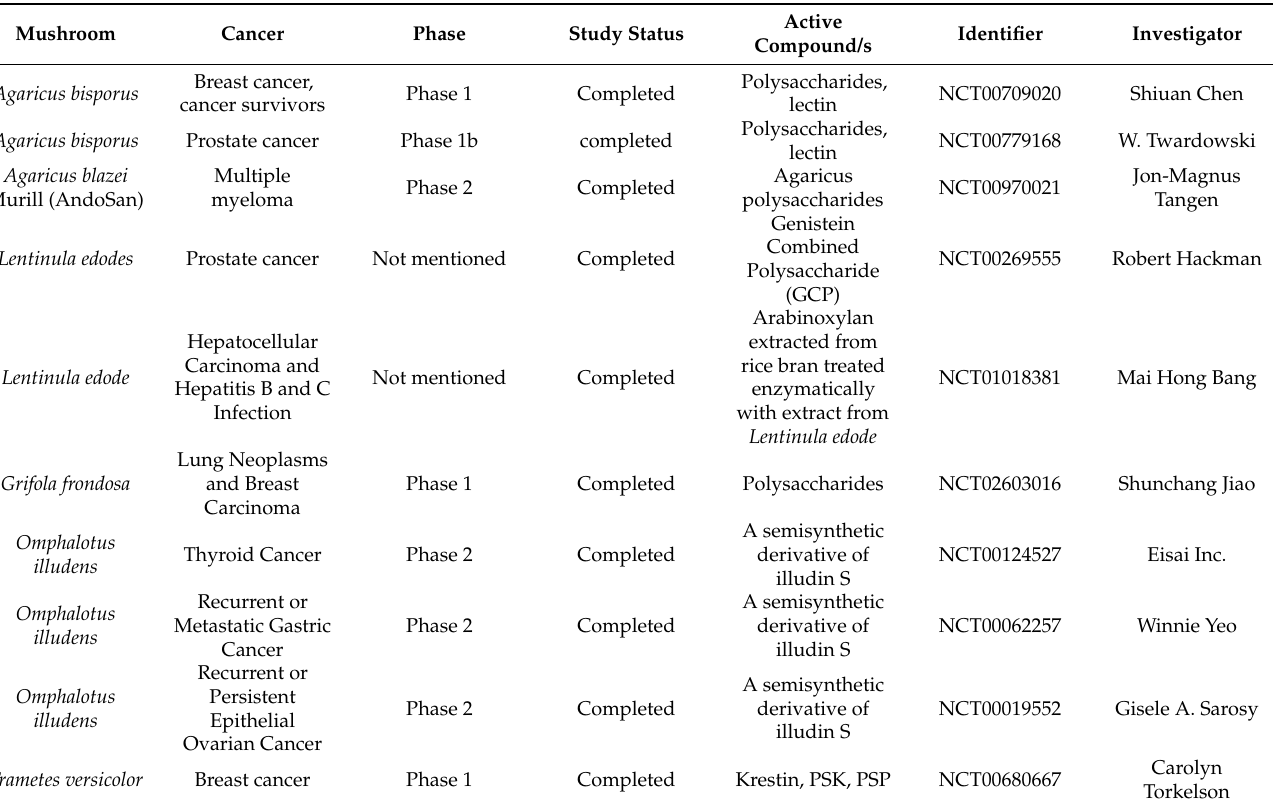
Table 1. Ongoing clinical trials for use of mushrooms in cancer